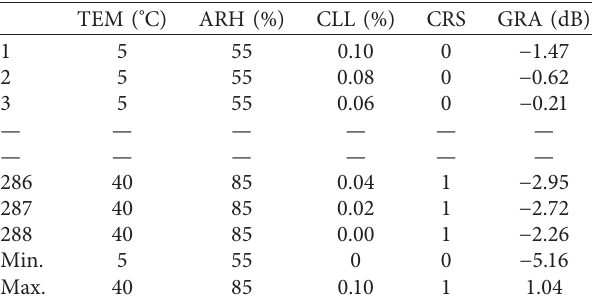
Table 3: Characteristics of the collected GPR data.